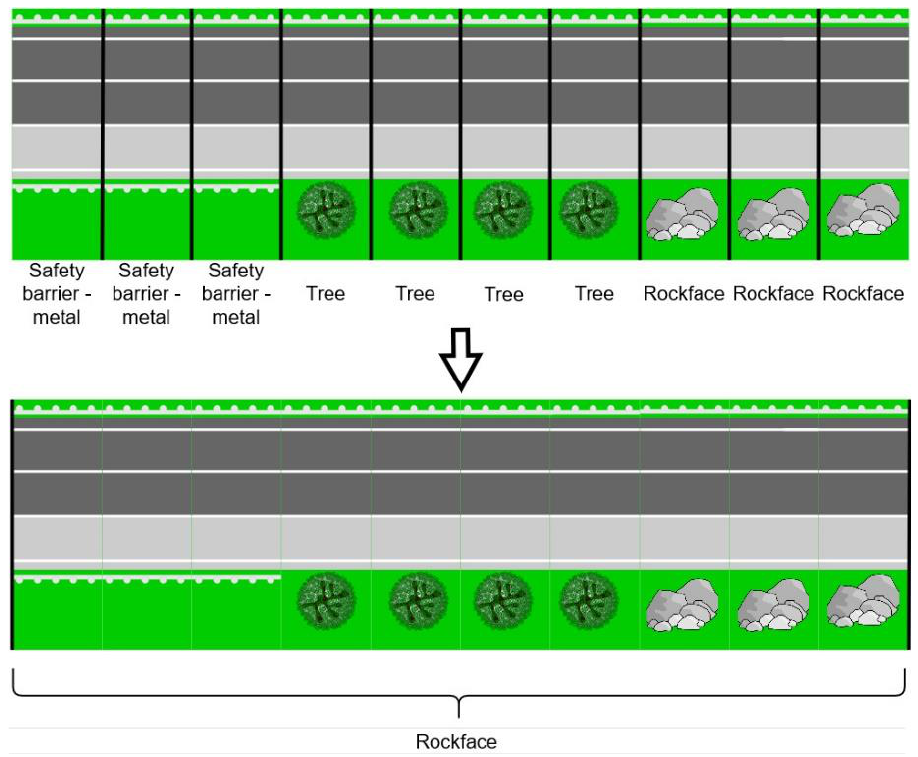
Figure 3. Example of upsampling 10 m road segments to one 100 m iRAP defined road segment. To perform object detection on point clouds, the detection method must be carefully selected. According to [34], there are three main methods for object detection on point clouds: projection-based methods (front view and bird’s eye view methods), voxel-based methods, and point-based methods. In this work, the frontal view method was chosen for object detection because the RSS–O and RSS-D are best distinguished from the road cross-section. In order to obtain front view images of road sections, i.e., images of road cross sections, the point clouds must be transformed from the Croatian Reference Coordinate System to a local coordinate system. The origin of the local coordinate system is at the center of the Lidar sensor, the x-axis is orthogonal to the vehicle path and the y-axis is in the direction of the vehicle path. The transformation process was performed by applying the equation: